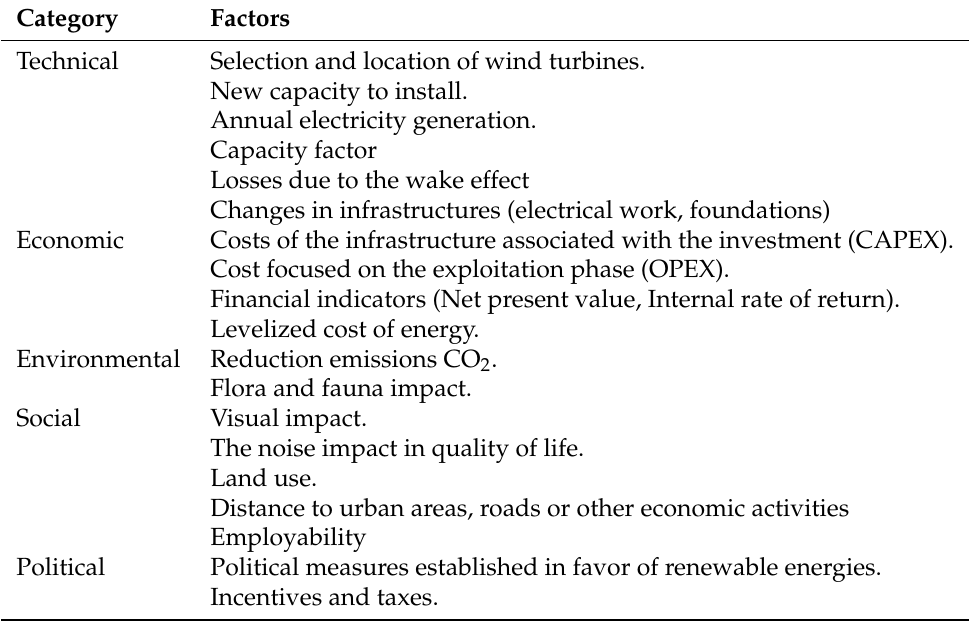
Table 1. Main factors by